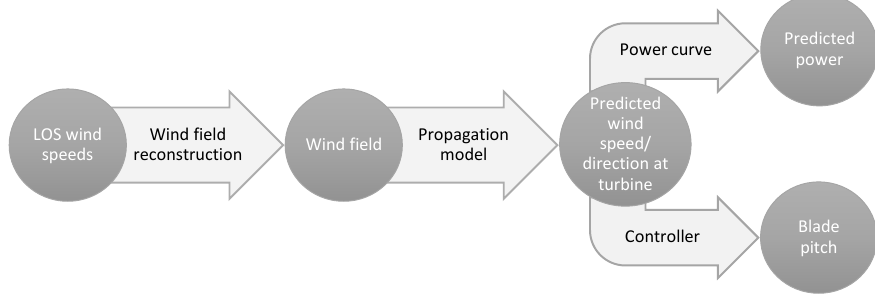
Figure 4. Forecast process using scanning lidar data.